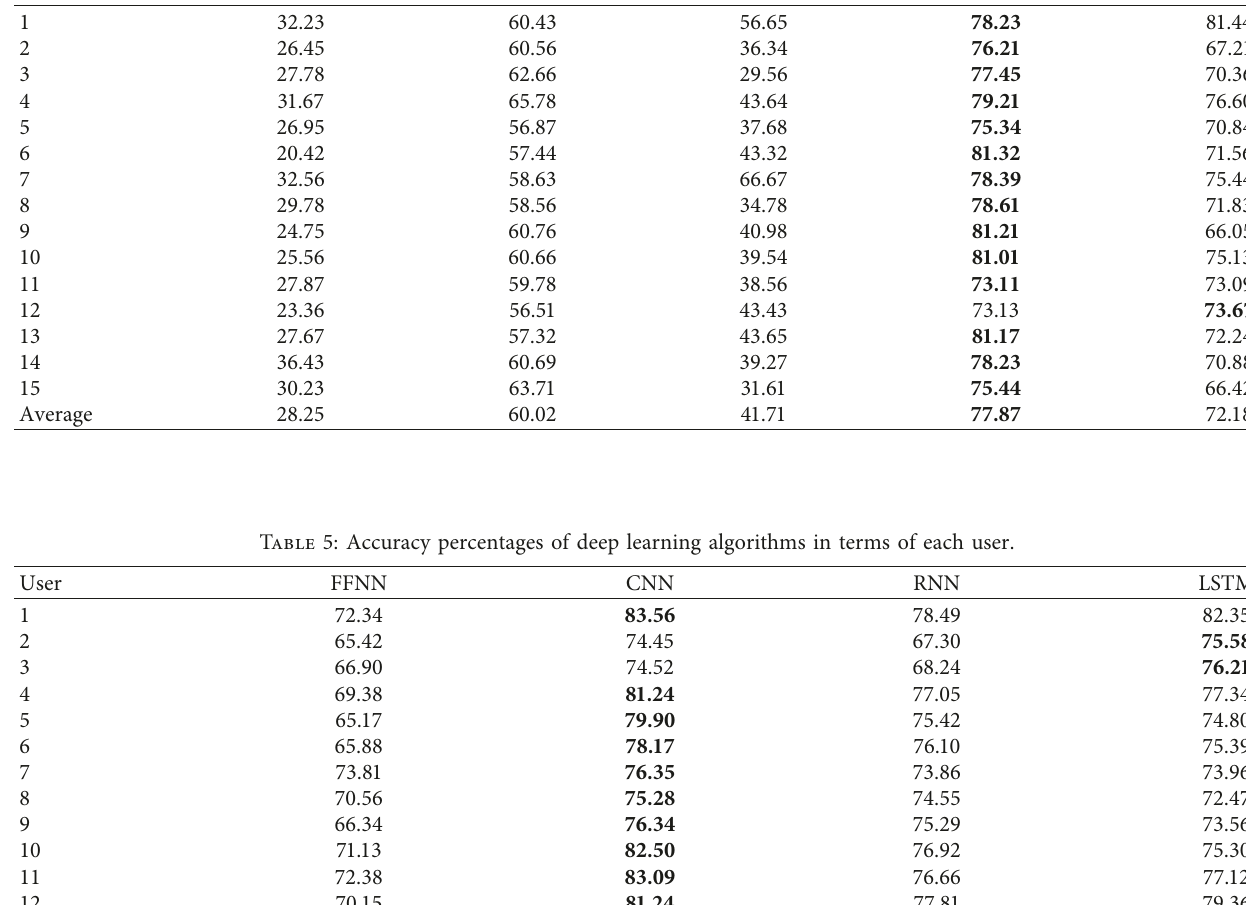
Table 4: Accuracy percentages of conventional machine learning algorithms and Decision Integration Strategy in terms of each user. User